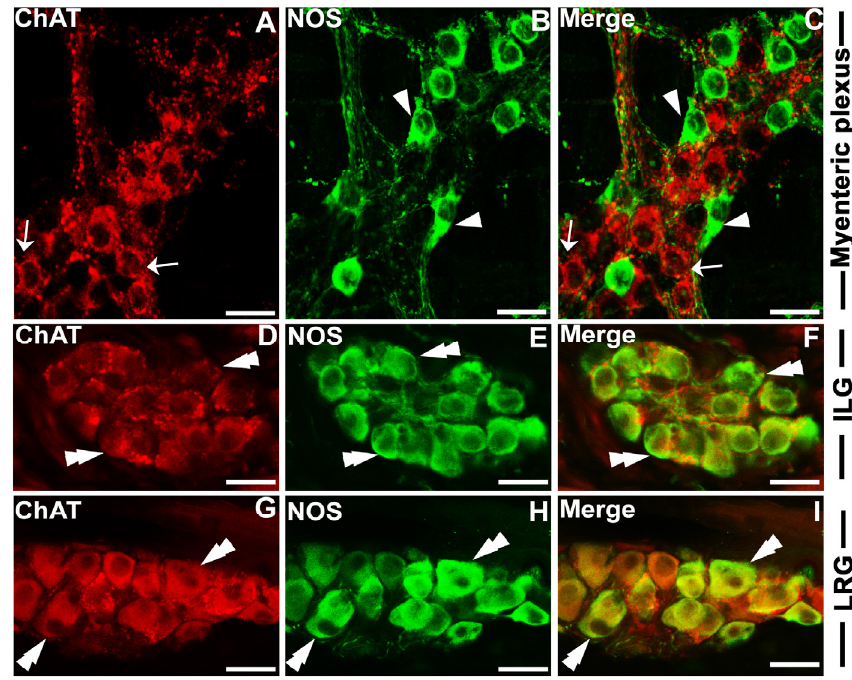
VIP ChAT, choline acetyltransferase; CGRP, calcitonin gene-related peptide; HAP1, Huntingtin-associated protein 1; NOS, nitric oxide synthase; NeuN, neuronal nuclei; SP, substance P; VIP, Vasoactive Intestinal Peptide. Values represented the mean SEM (n = 6).